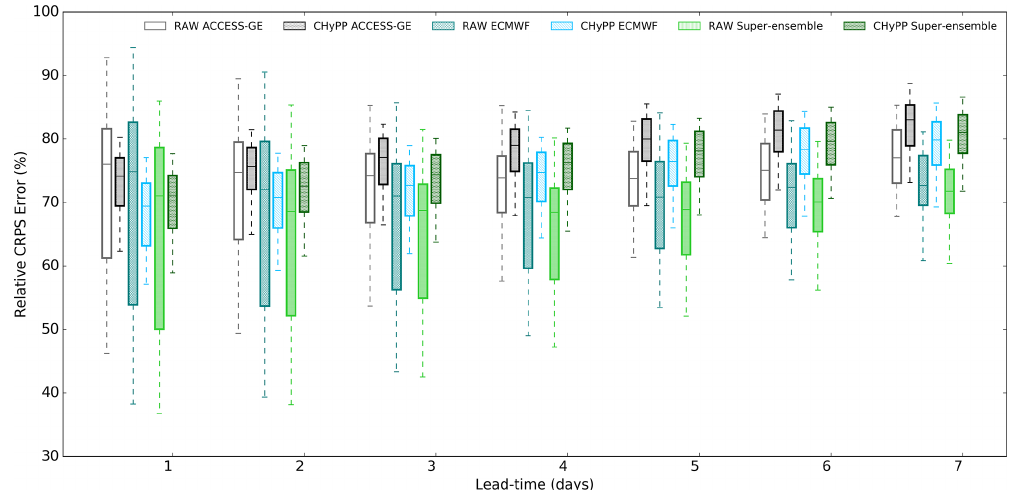
Figure 6. Relative CRPS (% of daily observations) of different rainfall products (raw and calibrated using CHyPP), ACCESS–GE2, ECMWF, and the super-ensemble for the 100